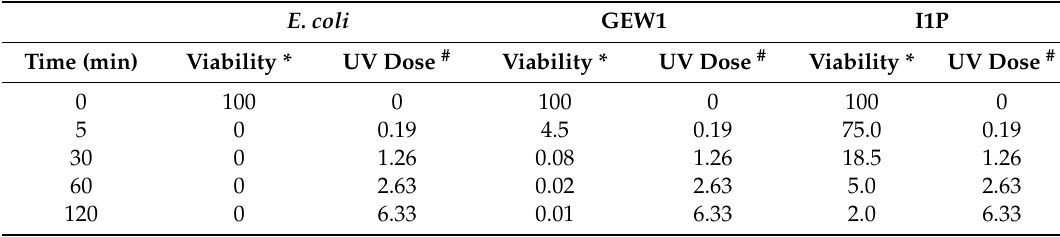
Table 2. Viability of cells exposed to UV-C radiation.